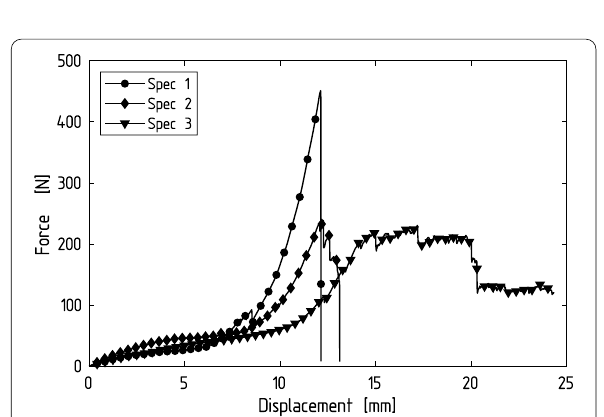
Figure 17 Force‑displacement curve for the climbing drum peel test